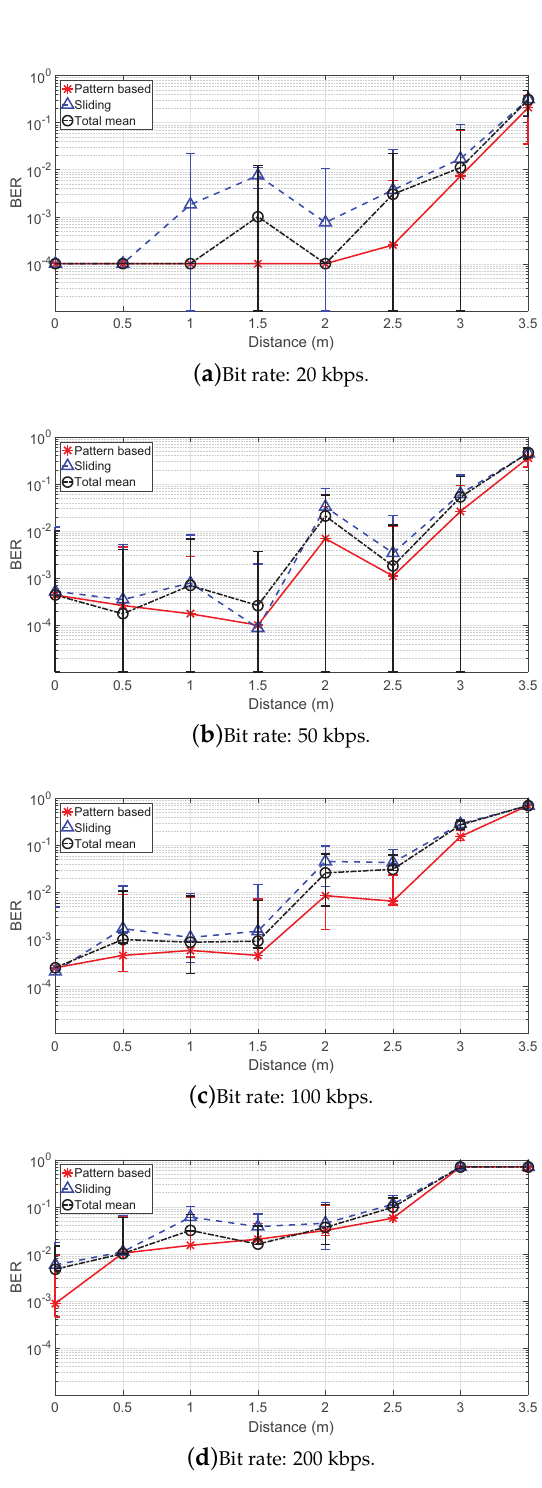
Figure 10. Bit error rate (BER) results for different tag